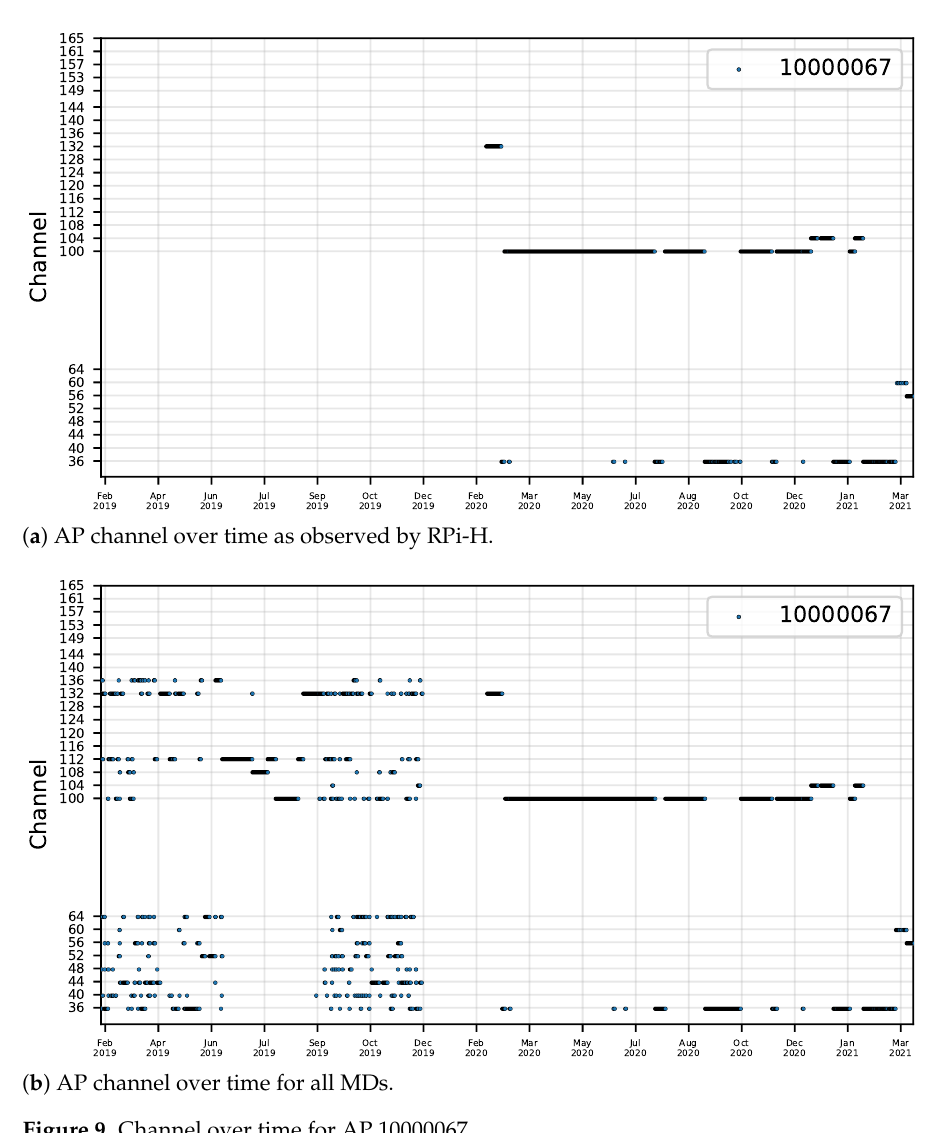
Figure 9. Channel over time for AP 10000067.